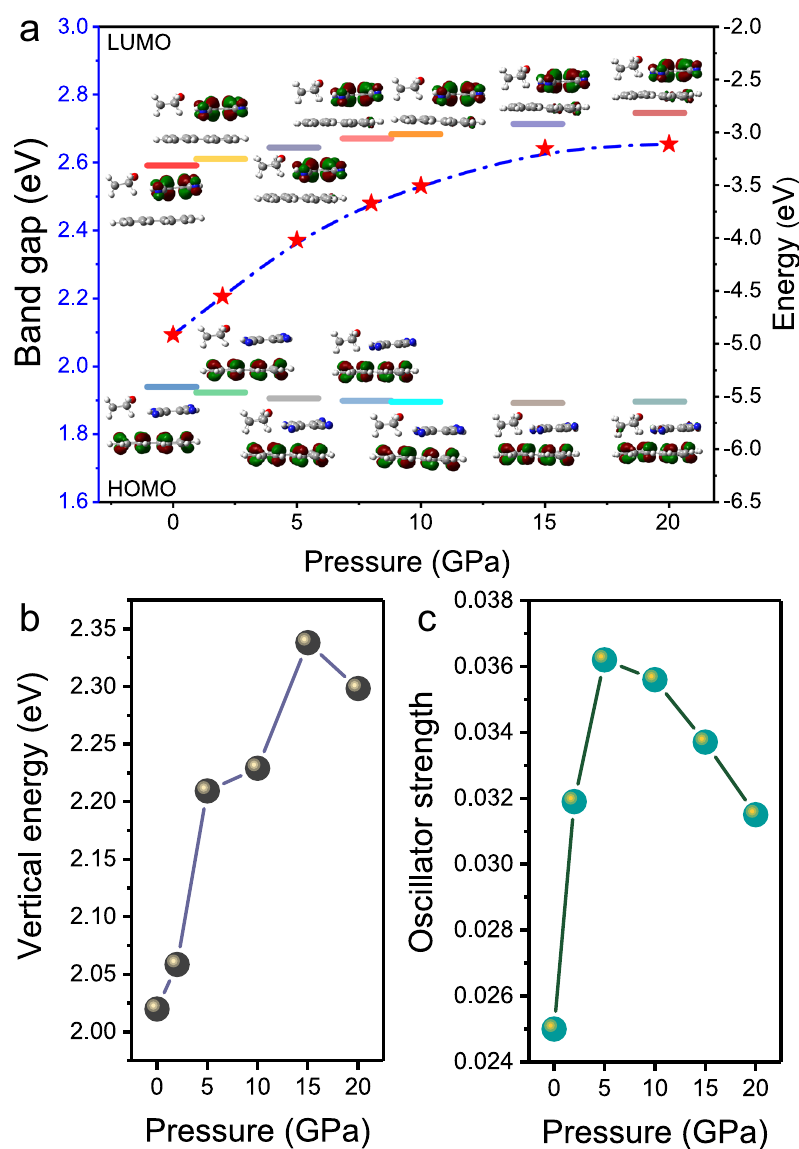
Fig. 5 Calculated MO and optical properties. a Calculated HOMO – LUMO energy gap (denoted by red star) of PTC – THF from 0 to 20 GPa. The inset shows the distribution of the frontier orbitals at different pressures. The calculated b vertical energy and c oscillator strength of PTCs – THF from 0 to 20